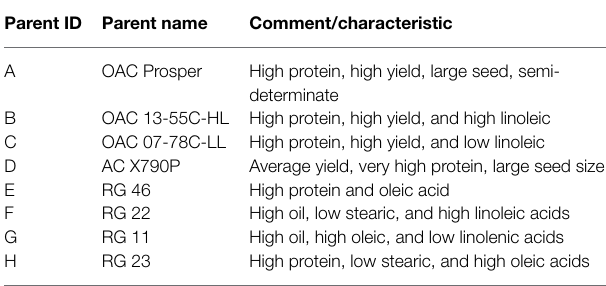
TABLE 1 | Descriptive characteristics of the parental lines for establishing the SoyMAGIC